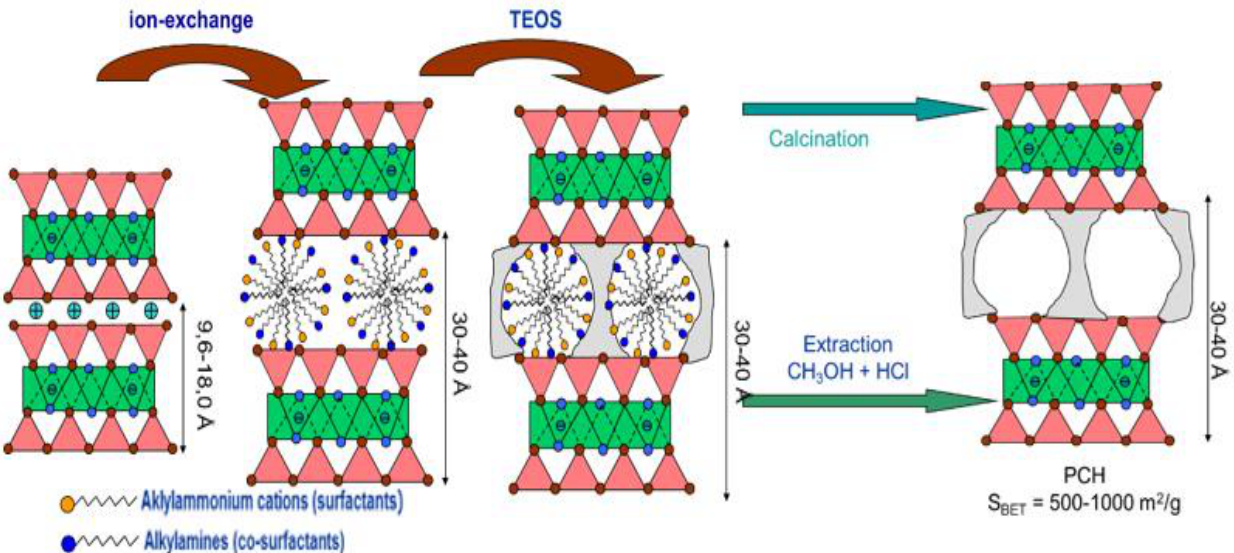
Figure 3. Synthesis of PCH materials. Tetraethyl orthosilicate (TEOS) was used as a precursor of interlayered silica pillars. Reprinted with permission from ref. [2]. Copyright 2018 Elsevier.